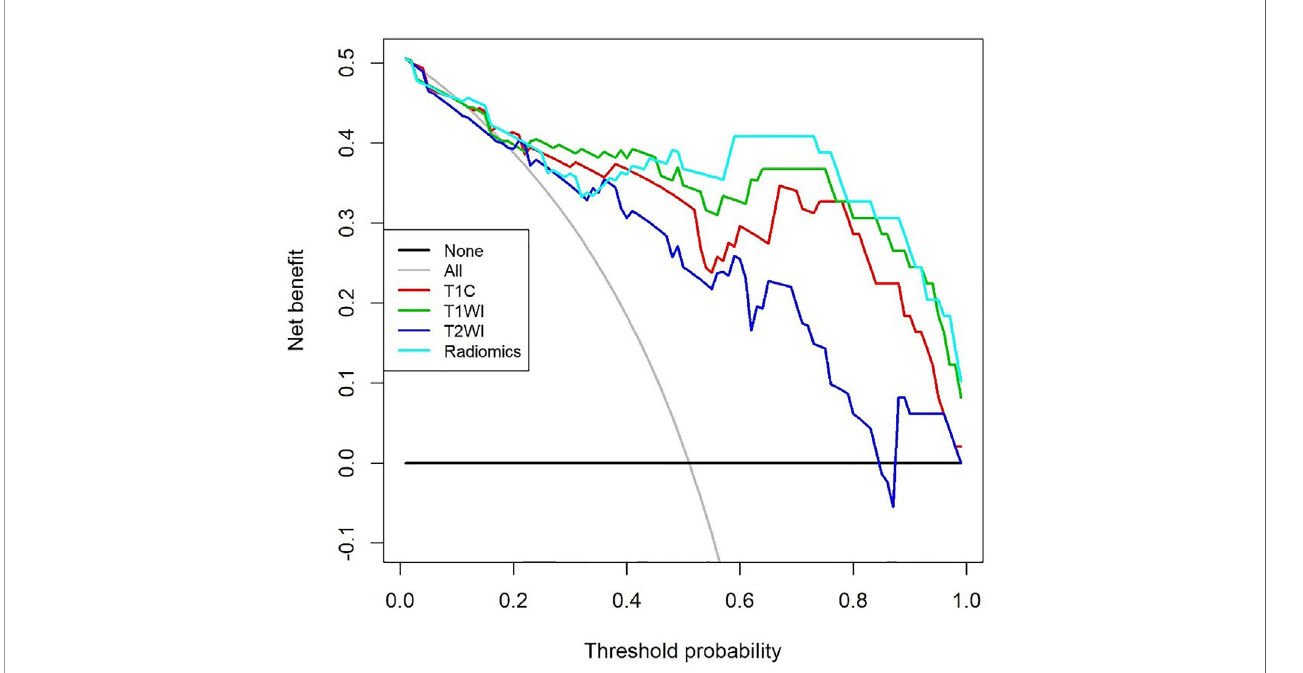
FIGURE 5 | Decision curve analysis for models from contrast enhanced T1WI (T1C), T1WI, T2WI, and Radiomics signatures in differentiating growth hormone- secreting adenoma subtypes. The decision curve showed that the prediction model had a better net bene fi t than either the treatment or no treatment schemes when the threshold probability was 0.254 to